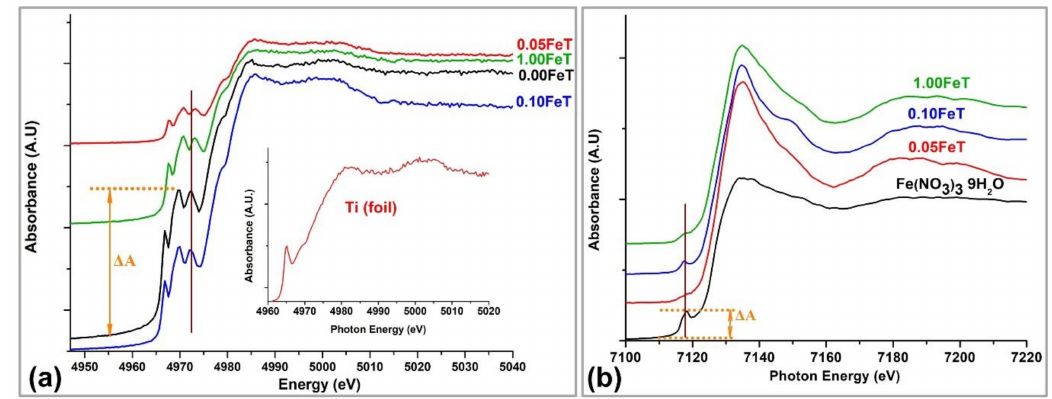
Figure 4. Ti K-edge ( a ) and Fe K-edge ( b ) XANES spectra for 0.00FeT, 0.05FeT, 0.10FeT, and 1.00FeT nanoparticles. XANES spectra of Ti foil and Fe(NO 3 ) 3 9H 2 O were used as reference samples. The brown cursors and yellow arrows indicate the pre-edge peaks position and height, respectively, of the reference